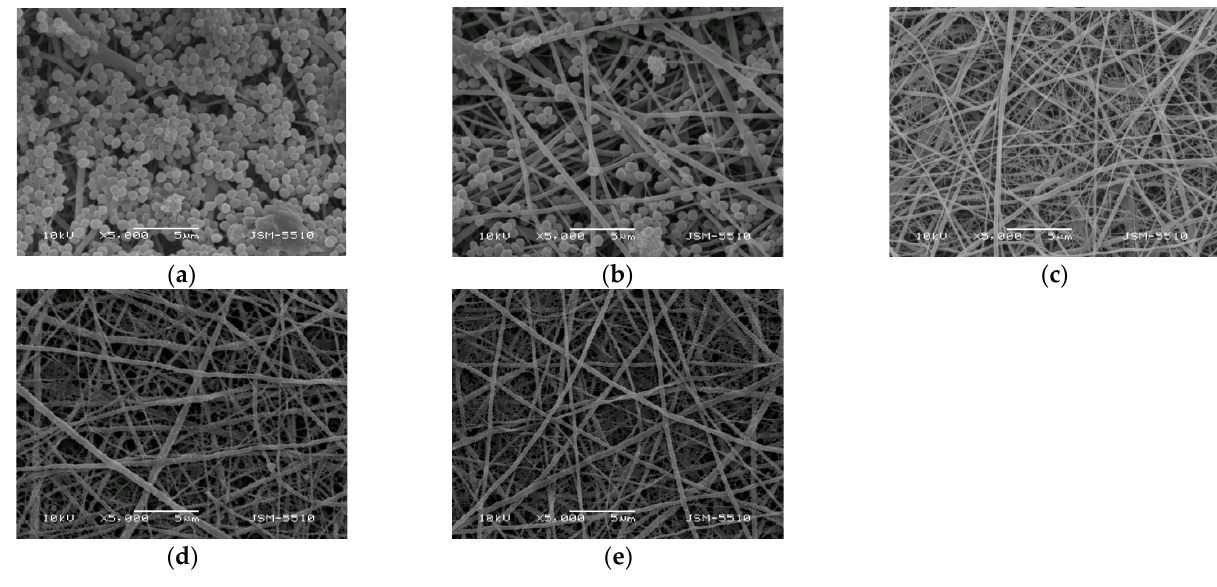
Figure 10. SEM micrographs of mats that have been incubated in S. aureus cell culture (10 7 cells/mL) for 24 h at 37 ° C, ( a ) PLA, ( b ) Ch/PLA, ( c ) Ch-8Q/PLA, ( d ) Cu 2+ complex of Ch-8Q/PLA and ( e ) Fe 3+ complex of Ch-8Q/PLA; magnification ×5000.